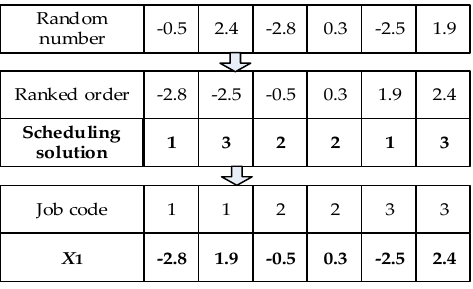
Figure 6. The conversion process from operation permutation to individual position vector.